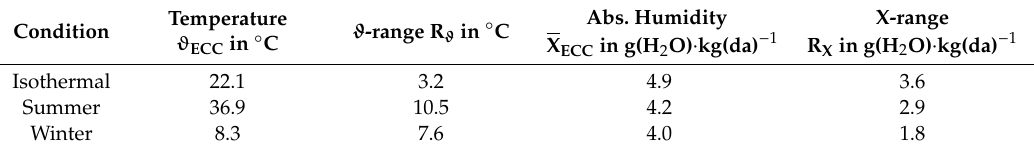
Table 5. Hygrothermal conditions in external climatic chamber (ECC) over 4 measurements each. Condition